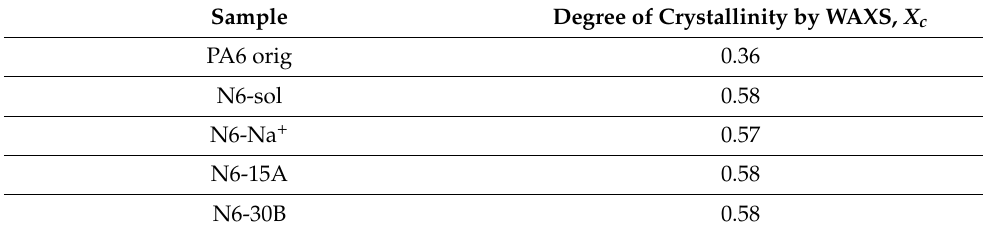
Table 2. Degree of crystallinity by WAXS, X c of the various